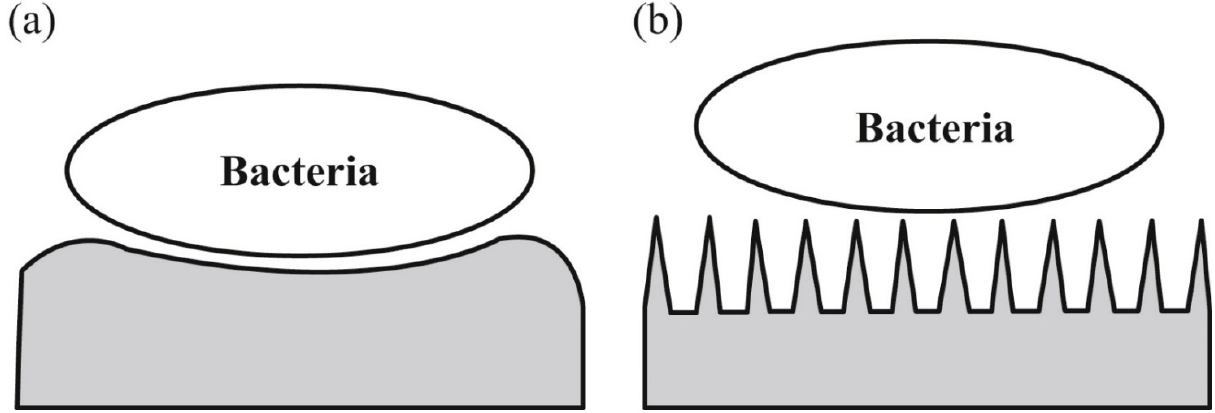
Figure 4. ( a ) Micron-sized elements can favor bacterial adhesion, ( b ) nano-sized features can produce problematic topo- graphic adhesion conditions (reprinted from an open-access source [67]).